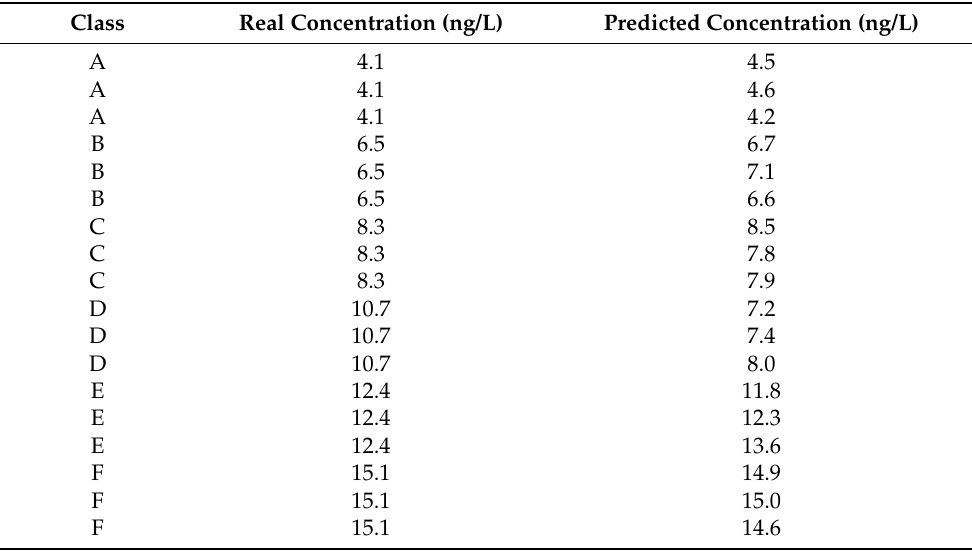
Figure 10. Results of the prediction model. Table 3. Real concentration and predicted concentration in ng/L.